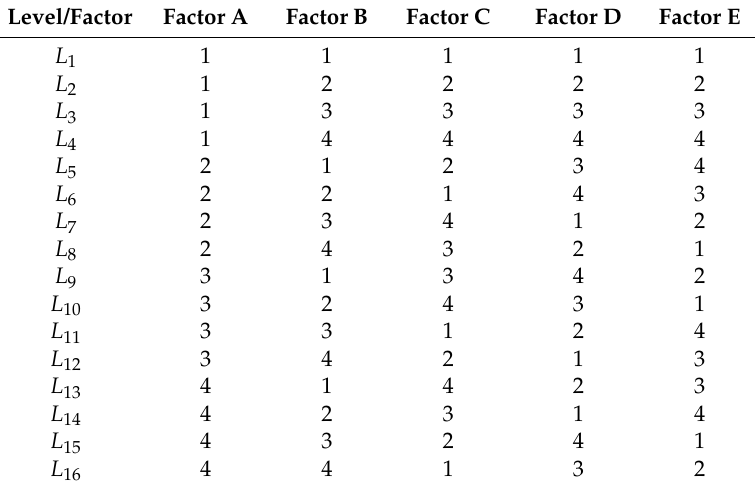
Table 3. L 16 (4 5 ) Orthogonal design list.